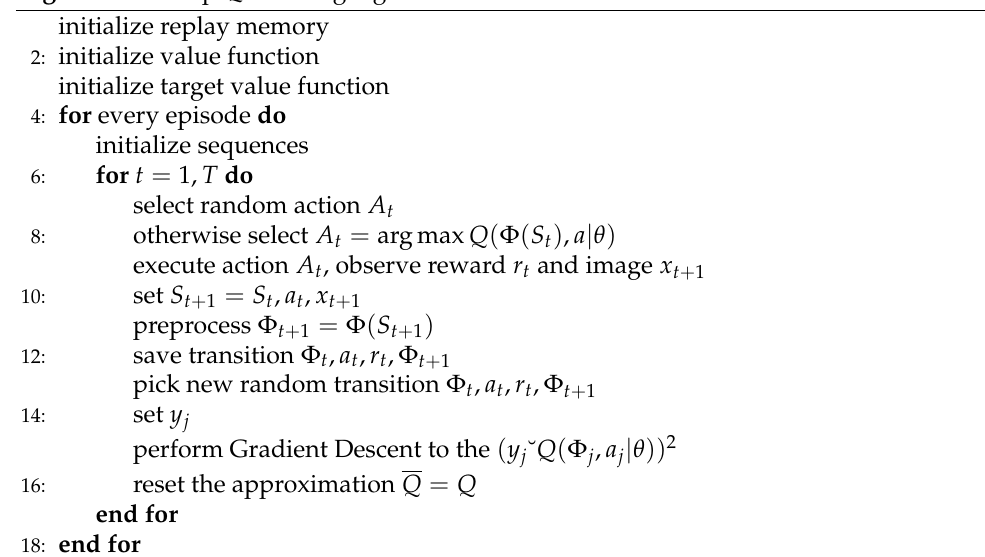
Algorithm 2 Deep Q–learning